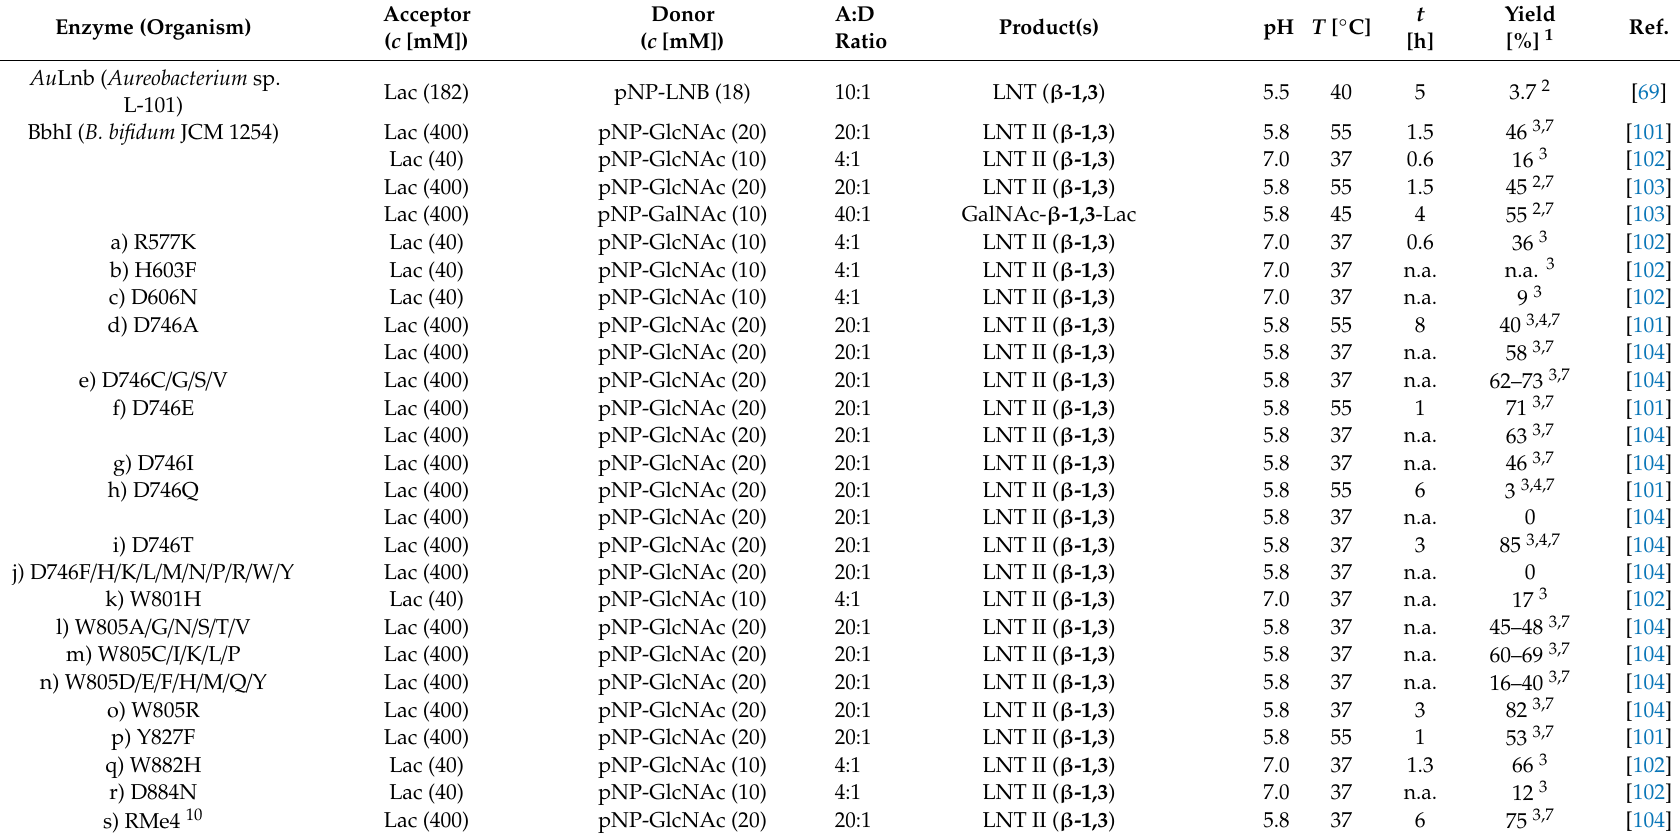
Table 5. Trans-glycosylation reactions catalyzed by bacterial GH20 enzymes using pNP-activated carbohydrate donor substrates. New bonds are highlighted in bold. Enzyme (Organism) Au Lnb ( Aureobacterium sp.